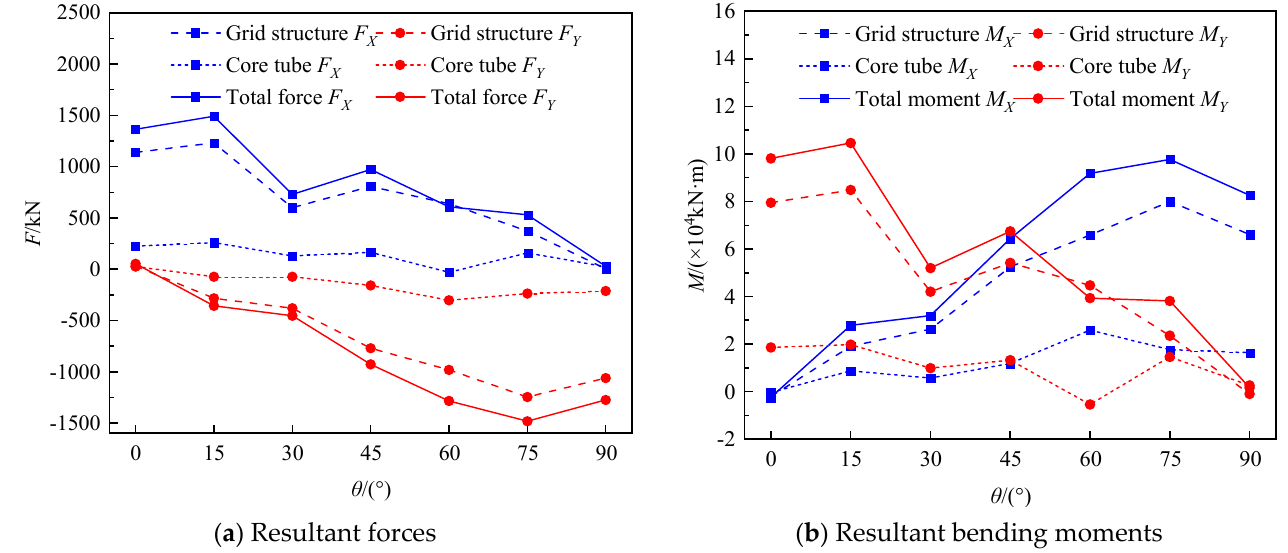
Figure 34. Mean wind load of the grid structure and core tube.